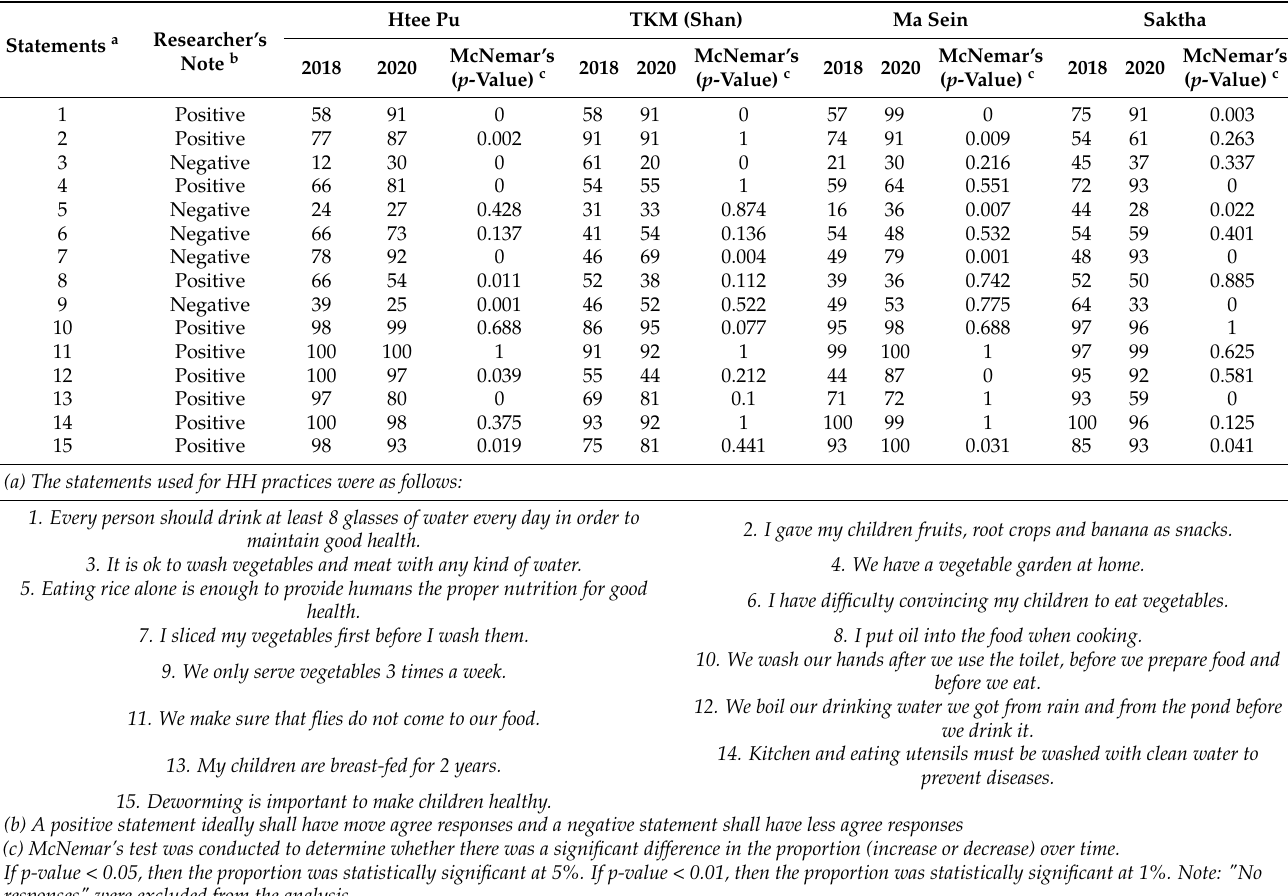
Table 8. Proportion of respondents who agree on the practice statements in household nutrition in four